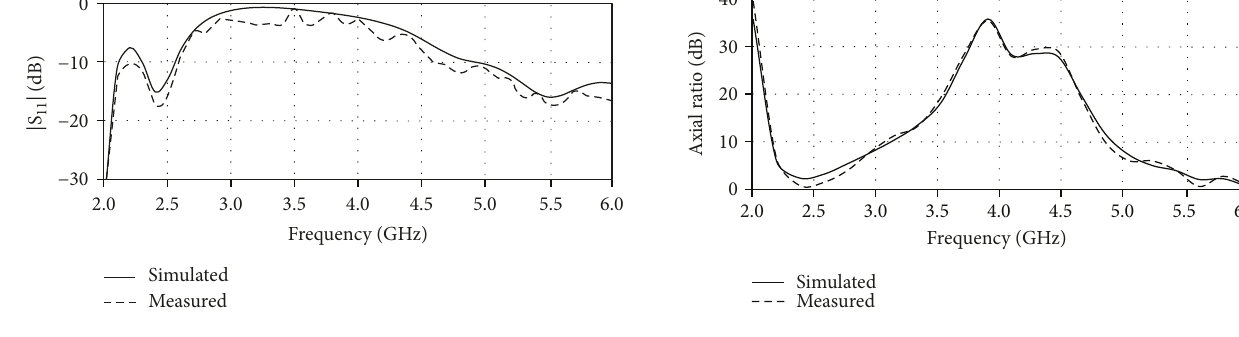
Figure 15: The simulated and experimental S frequency of the proposed antenna.